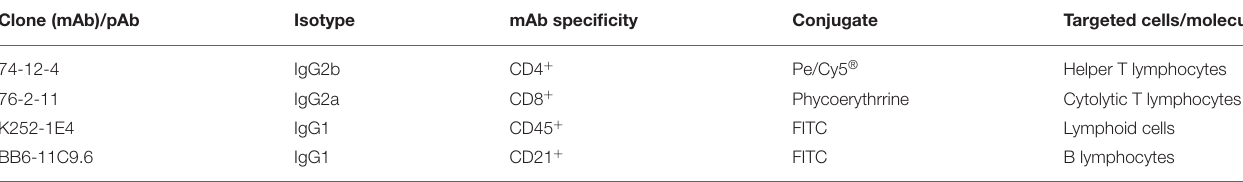
TABLE 3 | Murine monoclonal antibodies specific to swine leukocyte surface CD (cluster of differentiation) antigens and conjugates used in cytometric immunophenotyping of peripheral blood lymphoid cells from growing pigs fed with different Se sources and concentrations. Clone (mAb)/pAb